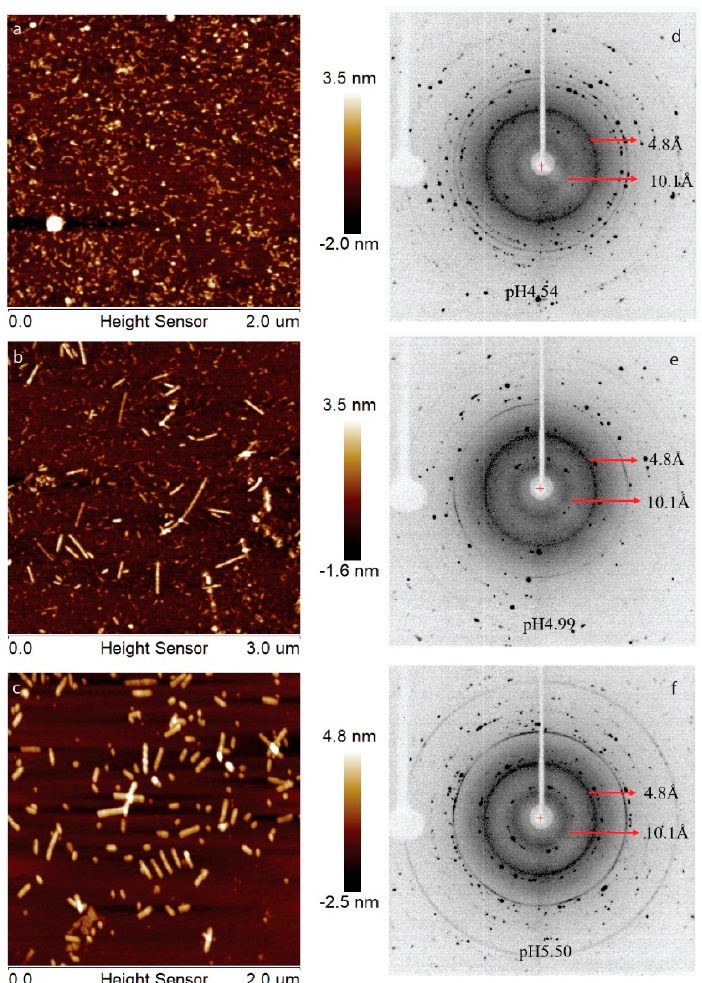
Figure 1. AFM images, ( a – c ), and XRD images, ( d – f ), of H175 assemblies prepared at pH 4.5, 5.0 and 5.5 at 37 ◦ C. ( a , d ) H175 assemblies at pH 4.5. The incubation period is 20 days. ( b , e ) H175 assemblies at pH 5.0. The incubation period is 20 days. ( c , f ) H175 assemblies at pH 5.5. The incubation period is 14 days. The arrows in XRD indicate the equatorial and meridional reflections at 10.1 Å and 4.8 Å, respectively. The other Debye rings in XRD indicate salt crystal reflection.